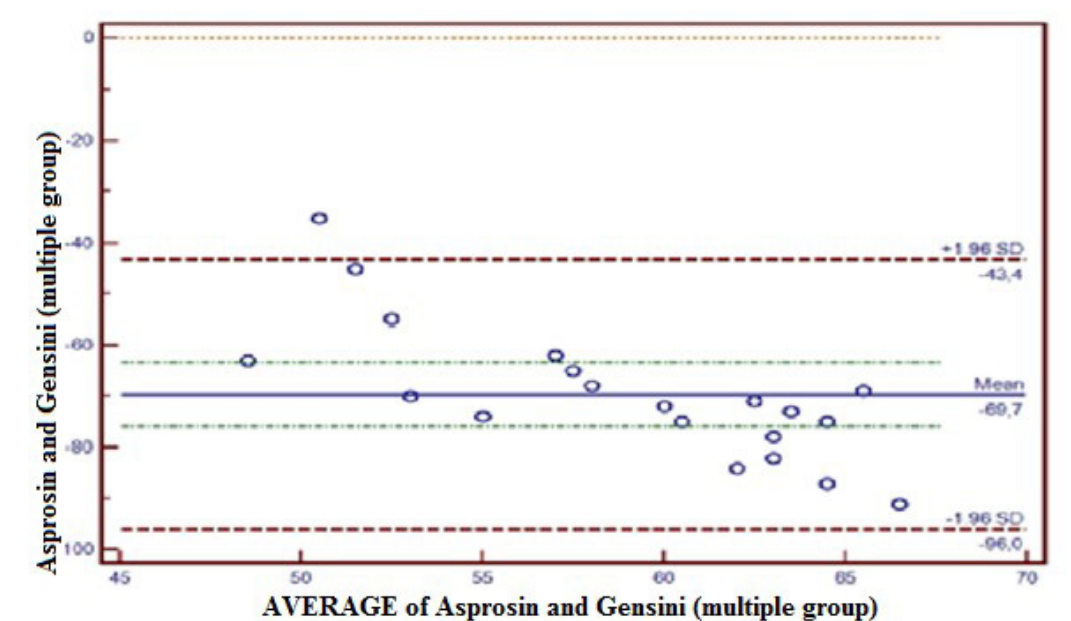
Fig. 5 - Concordance between Asprosin value and Gensini score in the multiple coronary lesion group. The concordance between Asprosin and Gensini by Bland-Altman method in the multiple coronary lesion group was -96.0 to 43.4 at a confidence level of 95%. Five percent (5%) of total observations was observed out of confidence level of 95%. SD=standard deviation